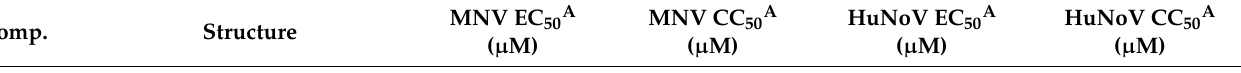
Table 1. Antiviral (MNV CPE and HuNoV GI replicon) and cytotoxicity data for the novel analogues 5–34. Results obtained for hits 3–4 are also included. Comp.